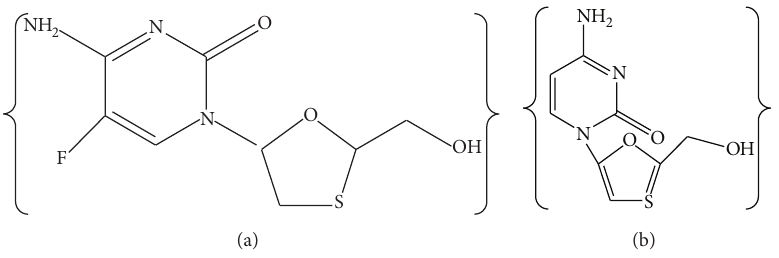
Figure 1: Chemical structure of emtricitabine (a) and lamivudine